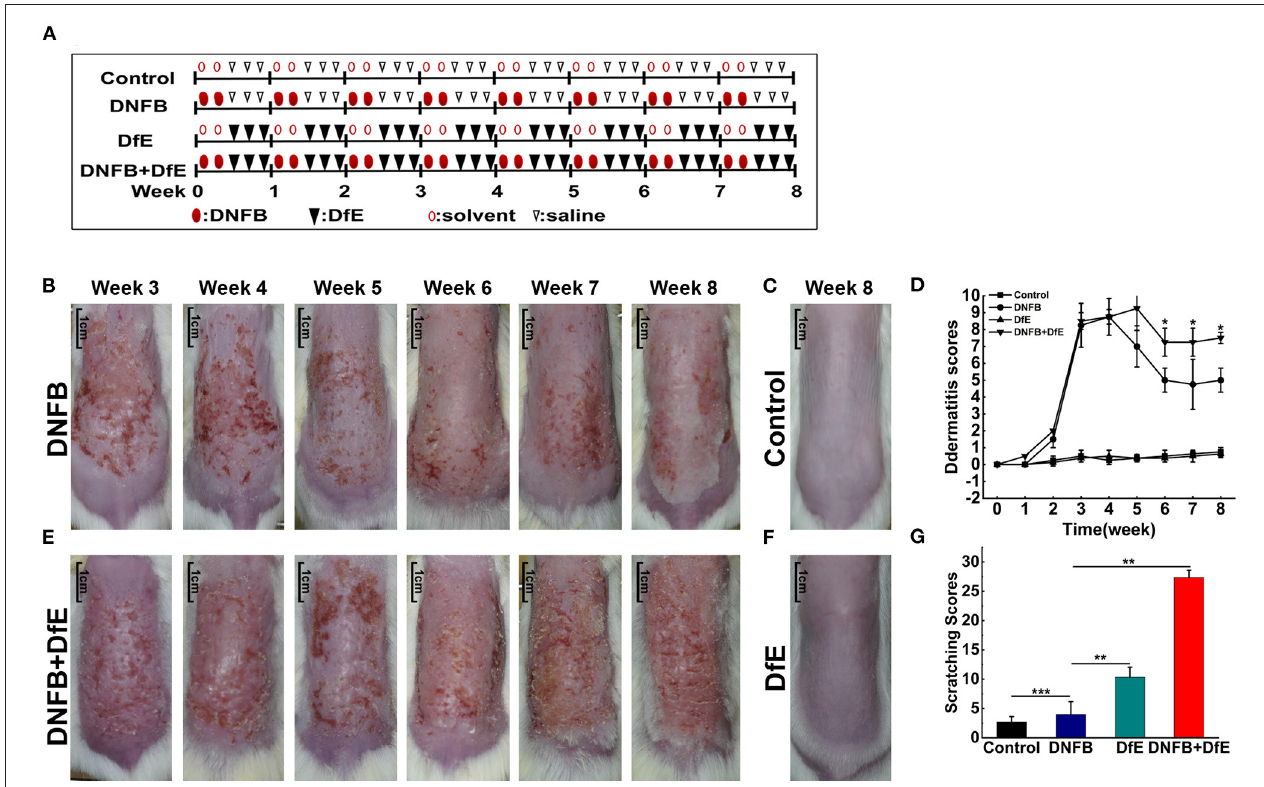
FIGURE 1 | Atopic dermatitis (AD)-like clinical features were induced by alternate application of dinitrofluorobenzene (DNFB) and an extract of Dermatophagoides farinae (DfE) in BALB/c mice. (A) Experimental design. BALB/c mice were randomly divided into 4 groups ( n = 4), including the control group, the DNFB group (100 µ L of 0.15% DNFB, two times a weeks), the DfE group (100mg DfE ointment, three times a weeks), and the DNFB + DfE group (alternate application of DNFB and DfE). The mice of the control group were alternately exposed to the solvent (a 3:1 mixture of acetone and olive oil) and saline. All reagents were repeatedly applied to the dorsal hairless skin for 8 weeks; (B–E) Skin lesions in the DNFB group, the control group, the DNFB + DfE group, and the DfE group. (Scale bar = 1cm); (F) Changes of dermatitis severity. Dermatitis scores were based on the symptoms of erythema, edema, dryness/scarring, and excoriation/erosion, and were compared between the DNFB + DfE group and the DNFB group ( n = 4 mice); (G) Scratching behavior after 7 weeks of treatment. The scratching behavior was expressed as points (as shown in Materials and methods) accumulated for 10min. Scratching scores are representative of three mice in each group. Data are showed as mean ± standard deviation (SD). * p < 0.05, ** p < 0.01, and *** p <